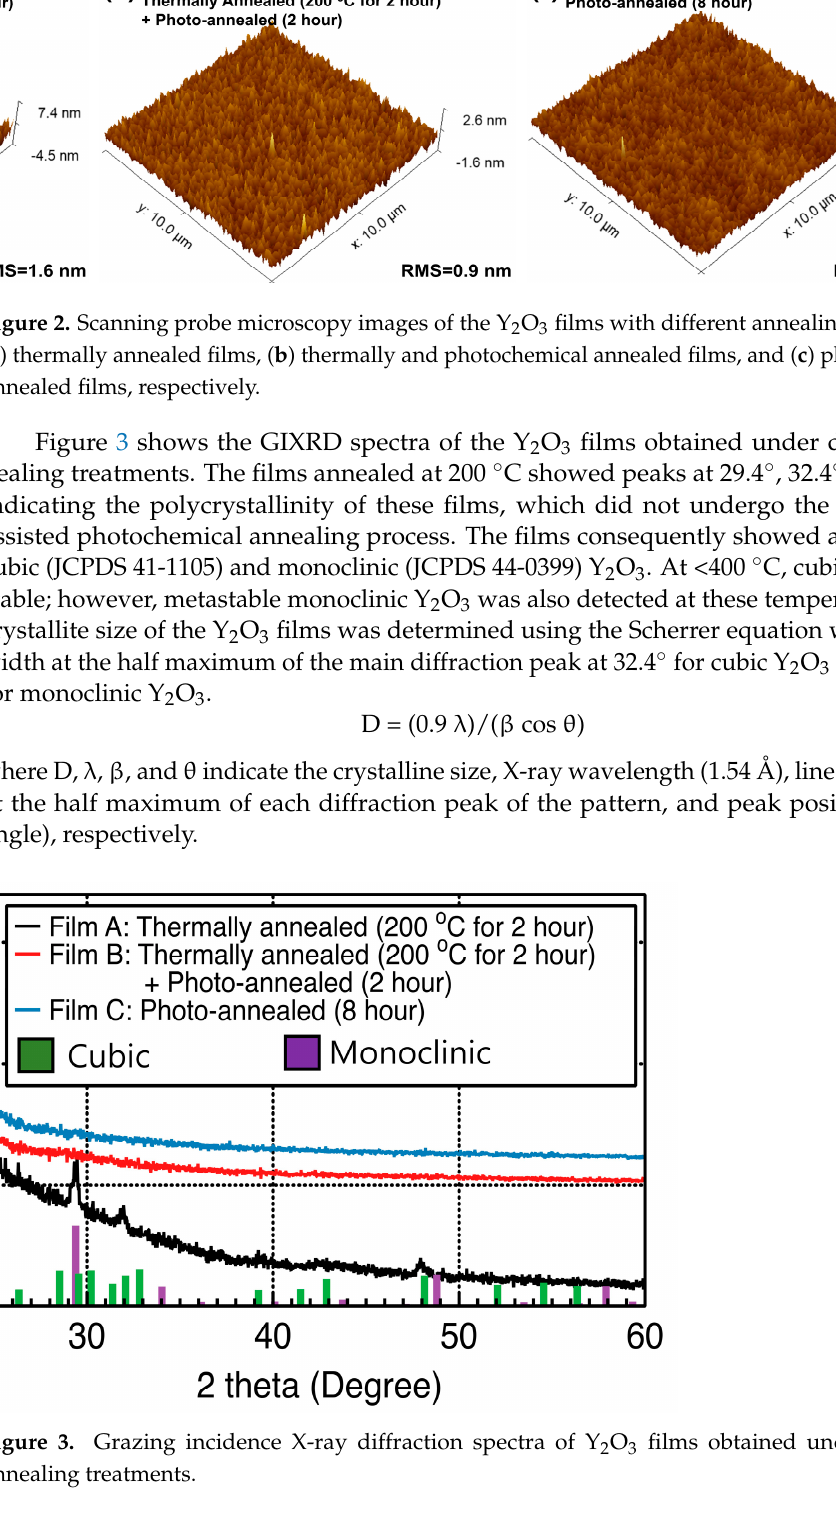
Figure 2. Scanning probe microscopy images of the Y 2 O 3 films with different annealing treatments: ( a ) thermally annealed films, ( b ) thermally and photochemical annealed films, and ( c ) photochemi- cal annealed films, respectively.